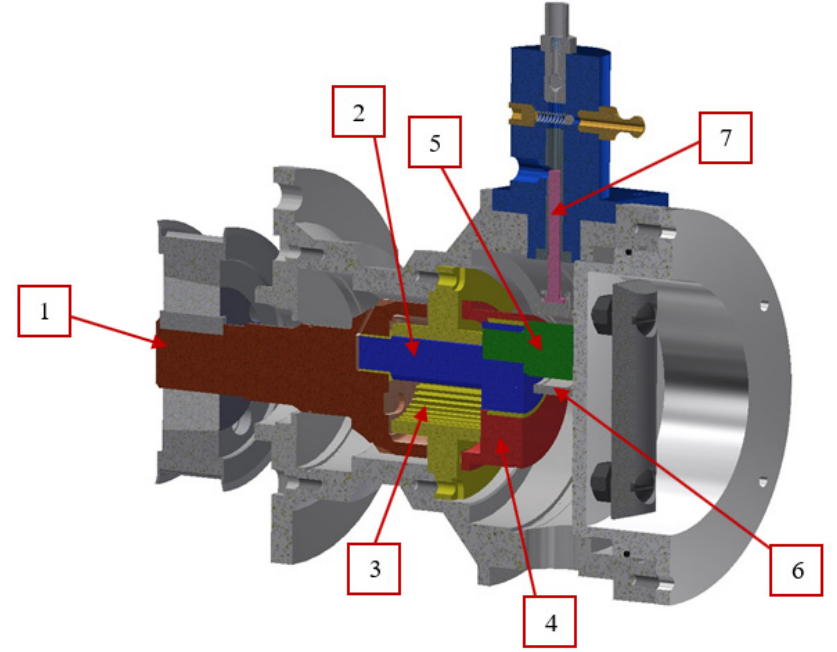
Figure 12. A simplified model of a hypocycloidal pump showing the most crucial components of the design: 1—main shaft, 2—countershaft, 3—toothed wheel, 4—support, 5—mandrel, 6—mount, 7—plunger.